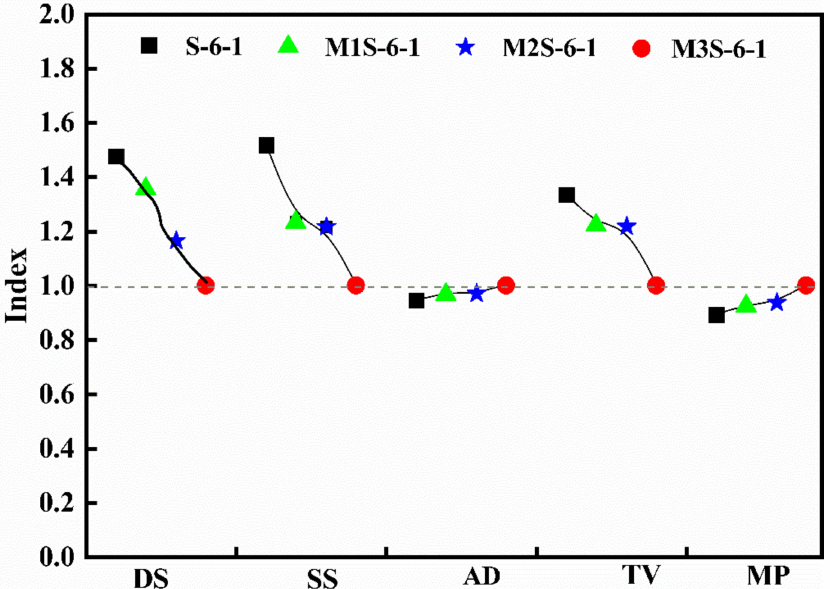
Figure 17. Influence of metakaolin on the drying shrinkage and pore structure characteristic parame- ters of alkali-activated slag.